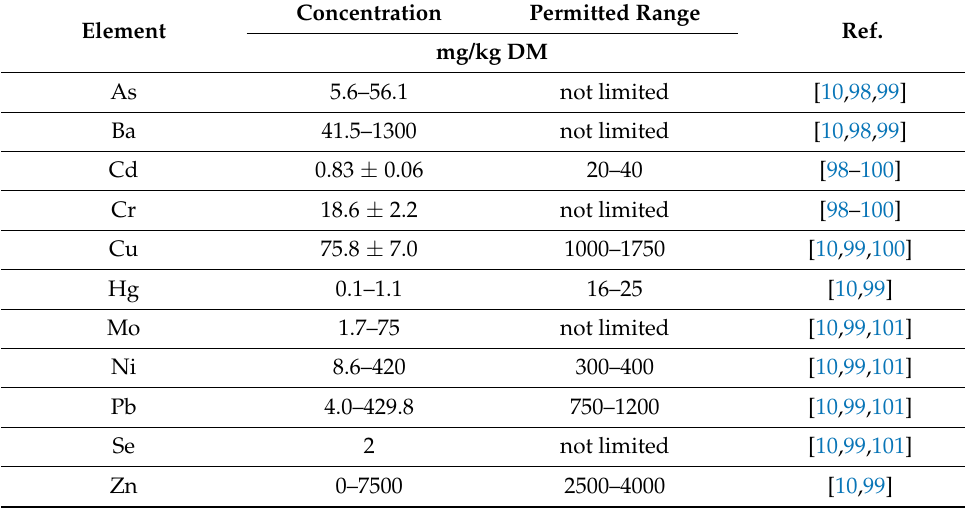
Table 2. Concentrations of heavy metals in sewage sludge.